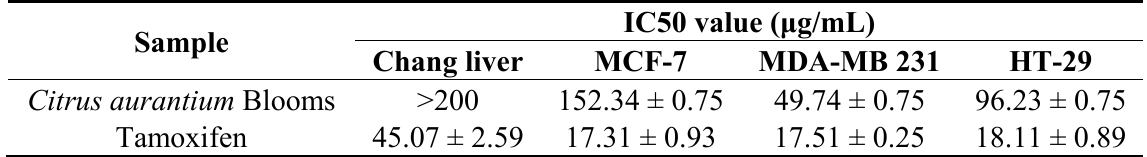
Table 5. The IC50 values of extracts and positive control on Chang liver, MCF-7, MDA-MB 231 and HT-29 cell